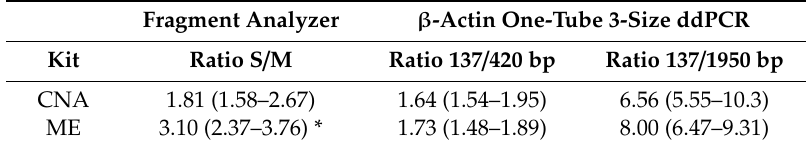
Table 2. Short- and medium-sized fragment percentages of citrate plasma as measured with the Fragment Analyzer.